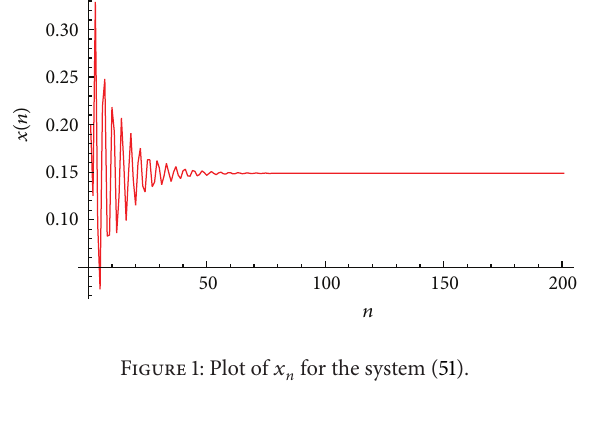
Figure 4: Plot of 𝑥 𝑛 for the system (52).